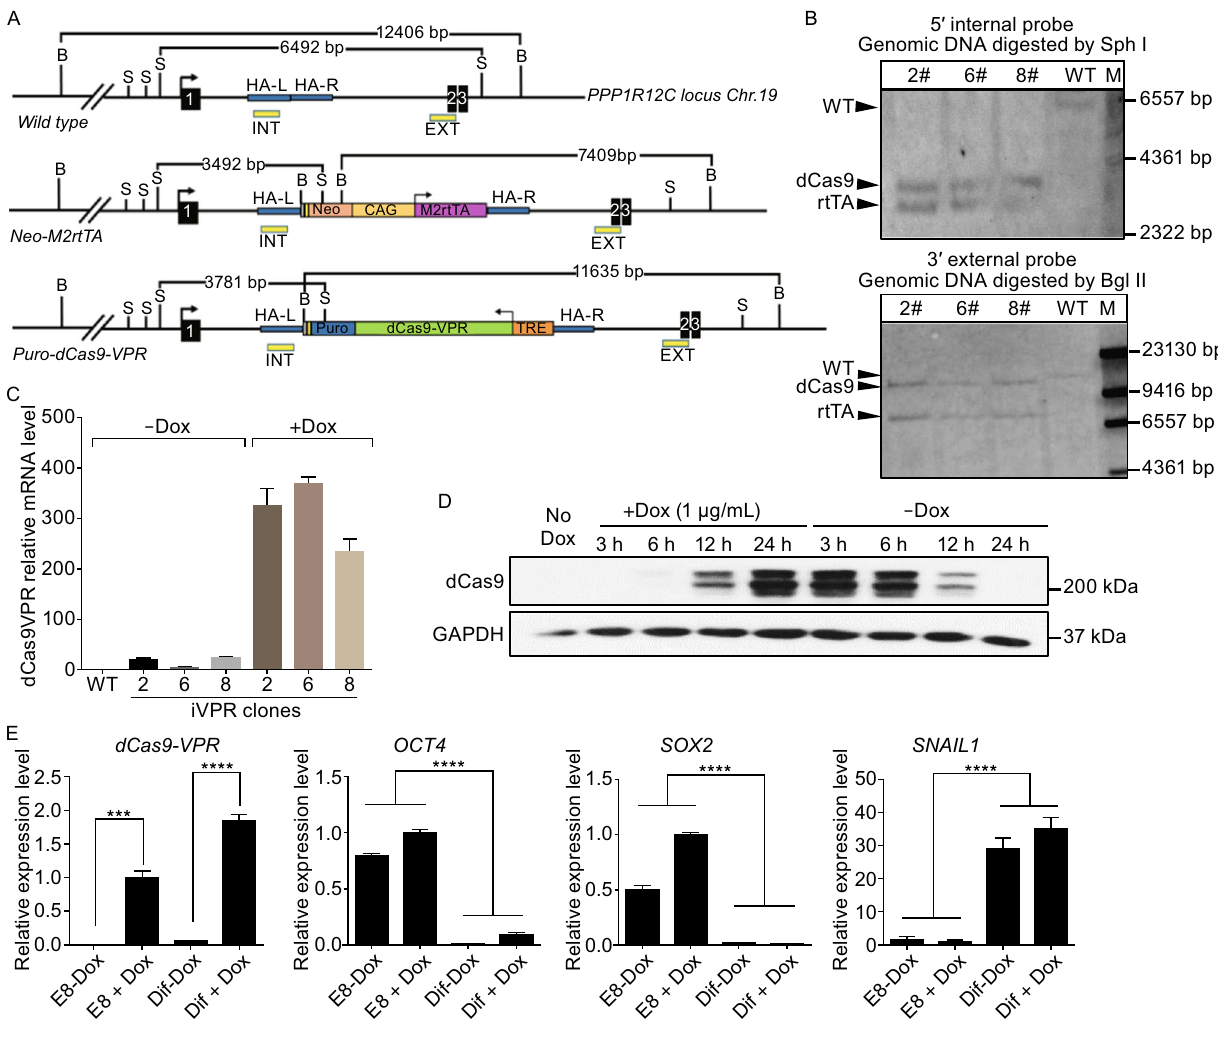
Figure 4. Generation of the iVPR hESC line. (A) Schematic view of wild type, targeted AAVS1 locus, and positions of Southern blot probes. B (Bgl II site), S (Sph I site), EXT (external probe), INT (internal probe). The sizes of the expected bands are indicated at the top. Blue lines indicate homology to the PPP1R12C intron. HA-L and HA-R, left and right homology arms. (B) Southern blot con fi rmed the correct targeted AAVS1 locus in the iVPR clone 2#, 6#, 8#. M, marker. (C) Q-PCR analysis of dCas9-VPR transcript levels with or without Dox treatment. Expression levels were normalized against GAPDH . Error bar represents SEM. (D) Western blot of dCas9- VPR protein level upon Dox addition and after Dox withdrawal in idCas9-VPR clone 2. The time points are indicated at the top. (E) Q-PCR showing that the induction of dCas9-VPR was not affected by differentiation. Cells were induced to undergo mesoderm differentiation for 3 days in the presence or absence of Dox. Gene expression levels were all normalized against GAPDH . Error bar indicates SEM. *** P < 0.001, **** P < 0.0001 , n =